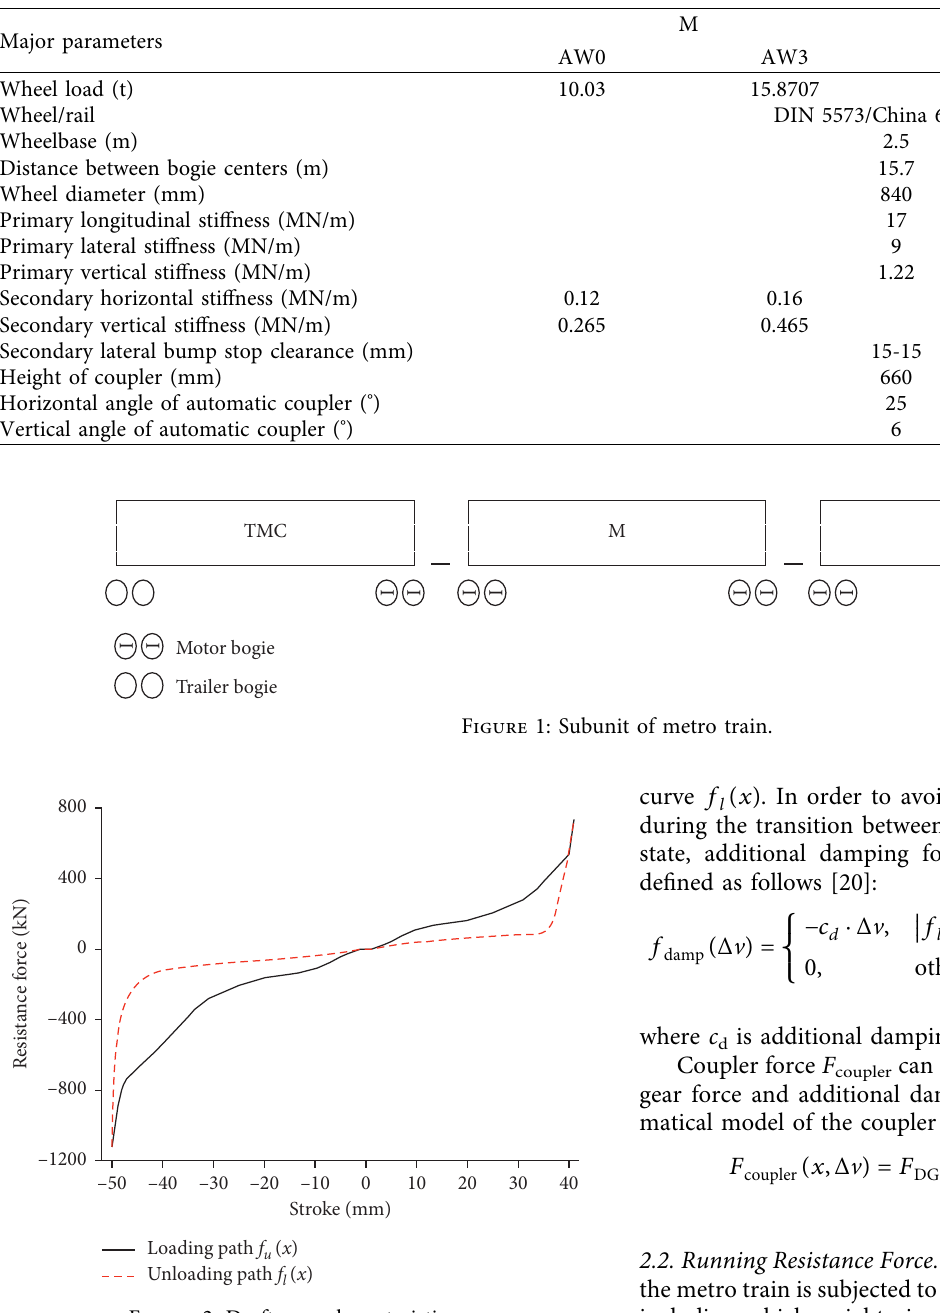
Table 2: Modeling parameters.